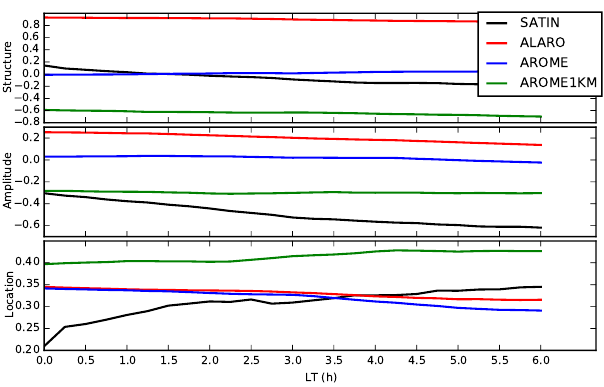
Figure 14. Comparison of pure (translational) nowcasting with NWP models on 15 May 2014: Structure, Amplitude and Location of forecasts per